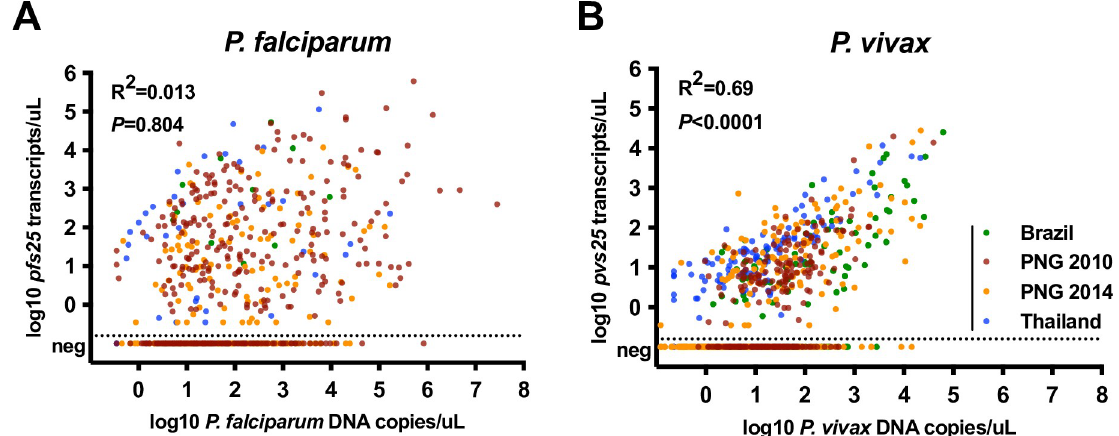
Fig 2. Relationship of P . falciparum (A) and P . vivax (B) parasite density by qPCR and pfs25 / pvs25 transcript numbers by RT-qPCR.